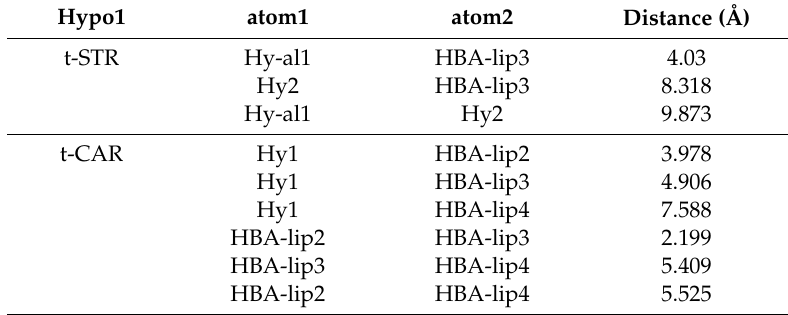
Table 6. Distances between features of the best significant hypotheses Hypo1_t-STR,